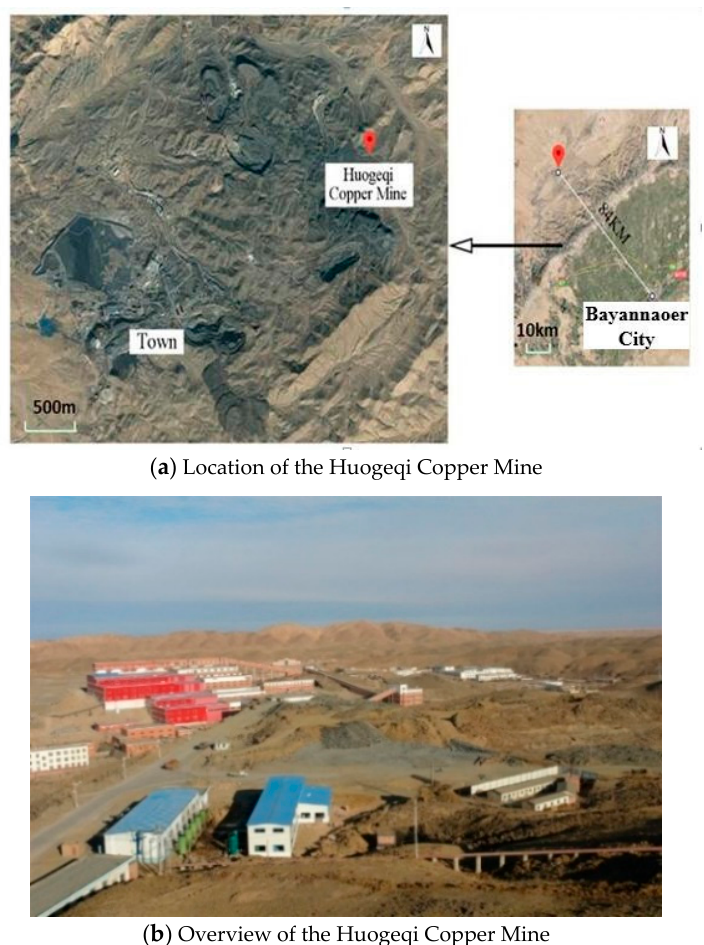
Figure 3. Location and overview of Huogeqi Copper Mine.